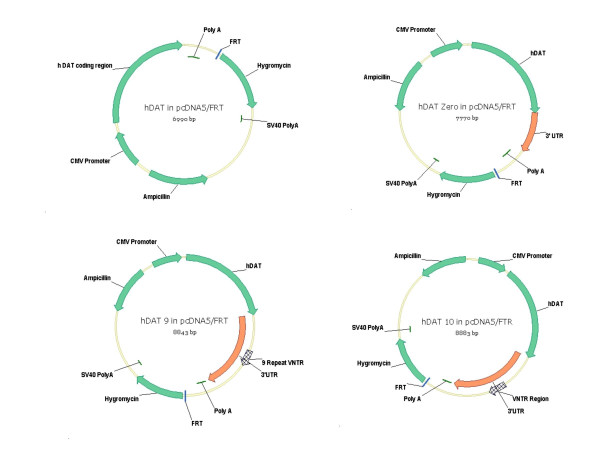
Summary of DAT1 constructs used in Flp-In recombination protocol. Top left: hDAT, DAT1 coding region necessary and sufficient to produce a functional transporter protein. Top right: hDAT Zero, a construct containing the DAT1 coding region flanked by an ~800 bp fragment of the 3'UTR upstream of the VNTR region. Bottom left: hDAT 9, a construct with the DAT1 coding region upstream of a full length 3'UTR harboring the 9-repeat VNTR. Bottom right: hDAT 10, a construct with the DAT1 coding region upstream of a full length 3'UTR containing the 10-repeat VNTR.